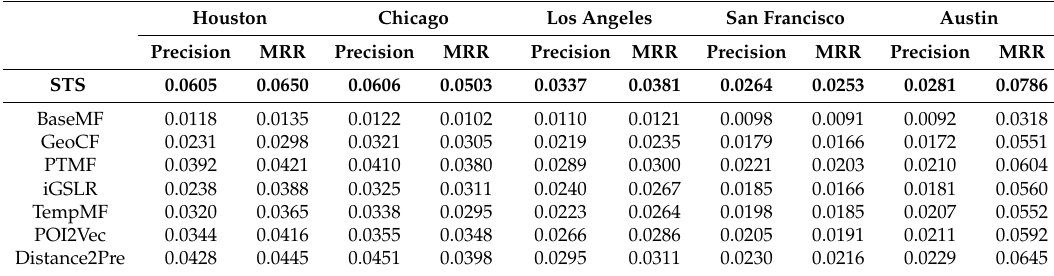
Table 3. Performance comparison (top-10 recommendation).